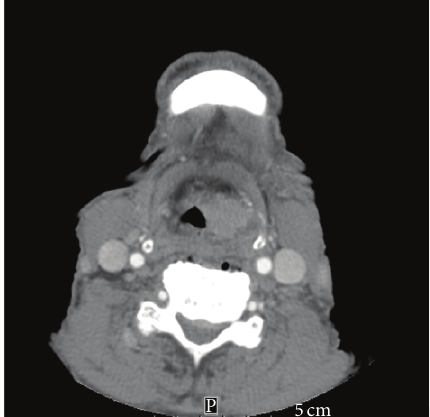
Figure 1: Neck CT showing patient’s left glottis